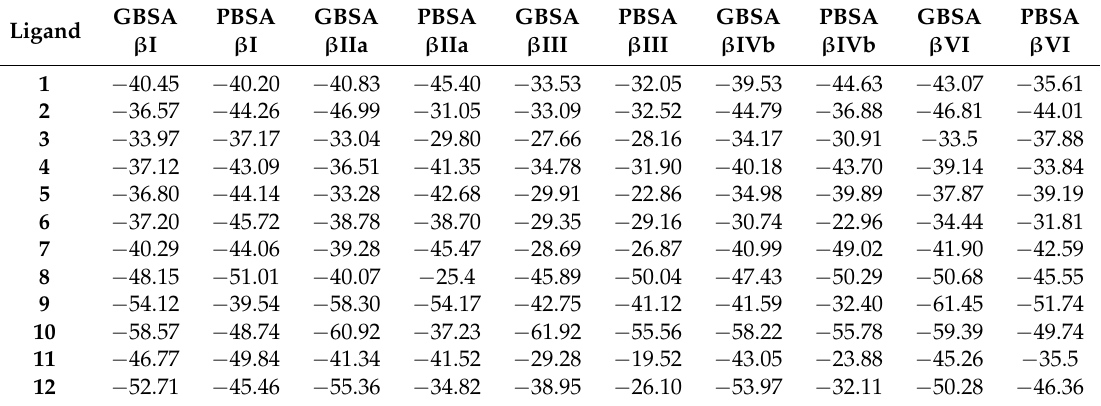
Table 4. Binding energies were calculated by MM/PBSA and MM/GPSA